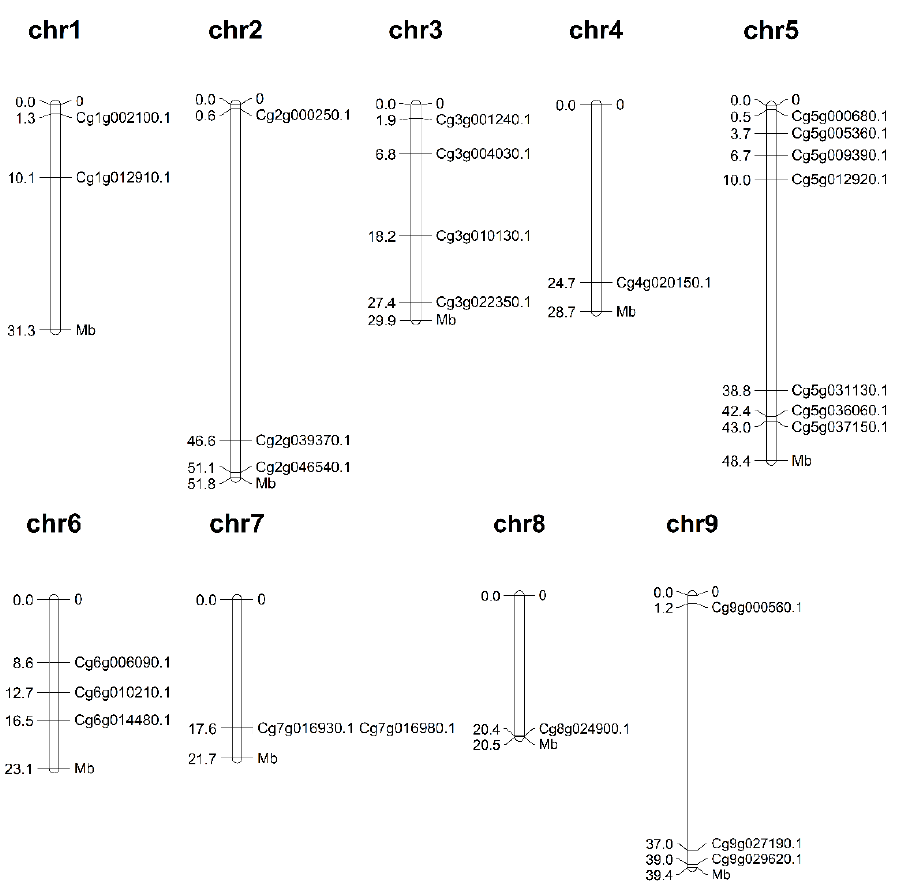
Figure 1. Chromosomal locations of m 6 A regulatory genes in C. grandis . The chromosomal position of each m 6 A regulatory gene was mapped according to the genome of C. grandis . The chromosome number is marked at the top of each chromosome and the unit for the scale is megabases (Mb).